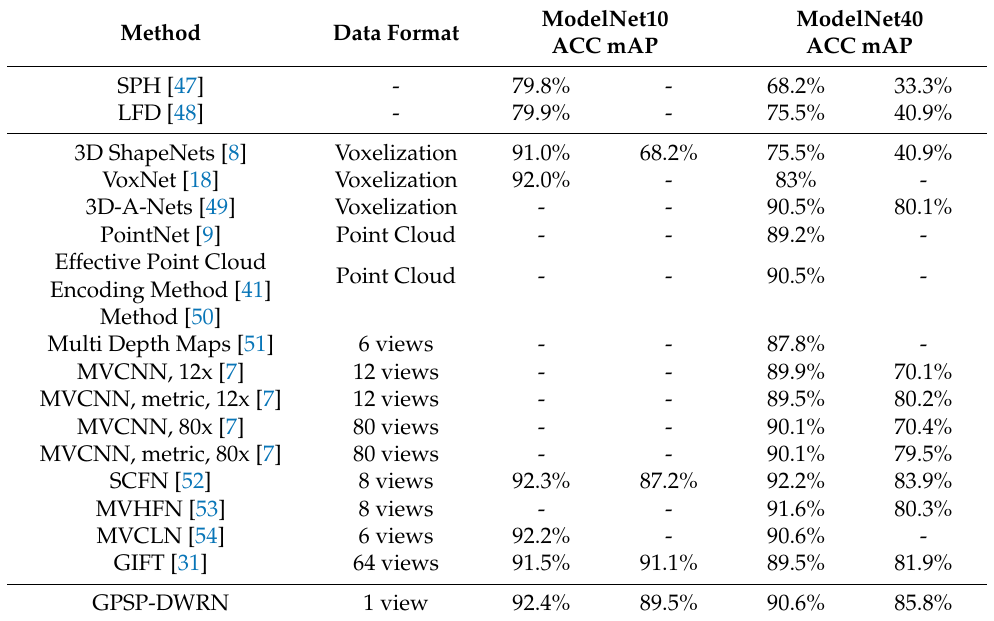
Table 2. Comparison with different methods on the